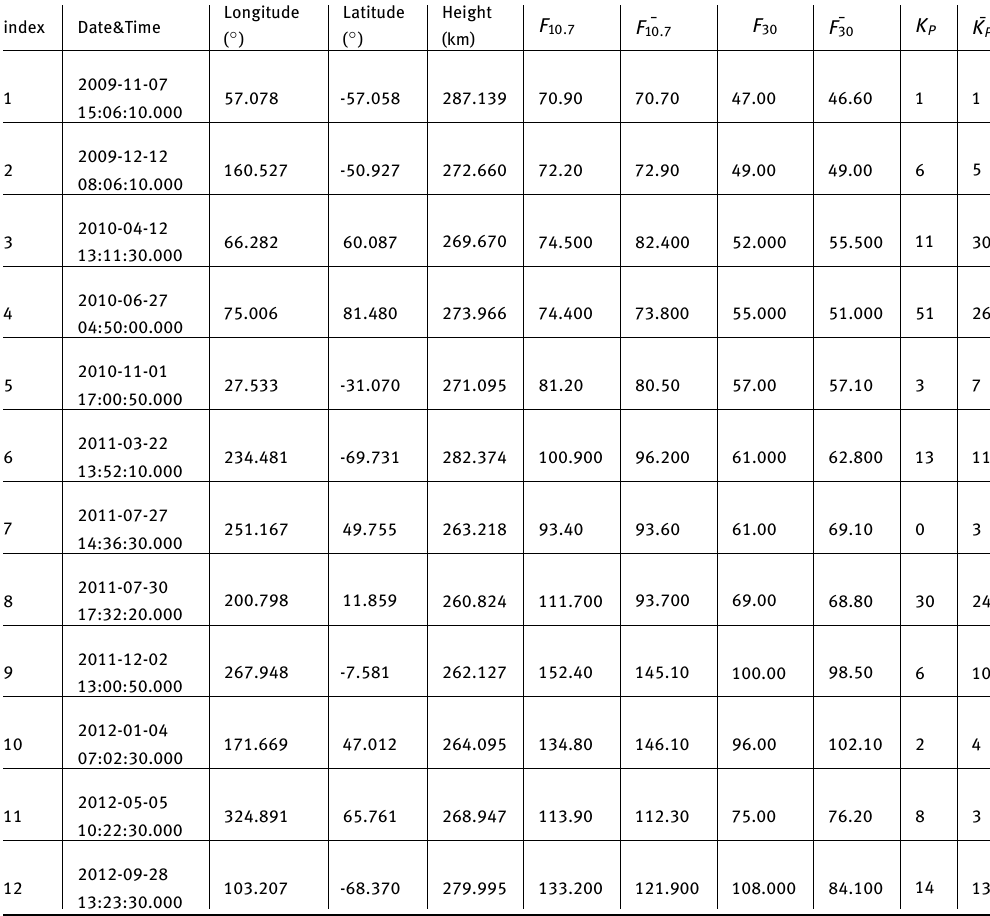
Fig. 7. Global atmospheric density F 30 neural networks model simulation results in March 2012 Table 1. Input data of GOCE orbit sampled